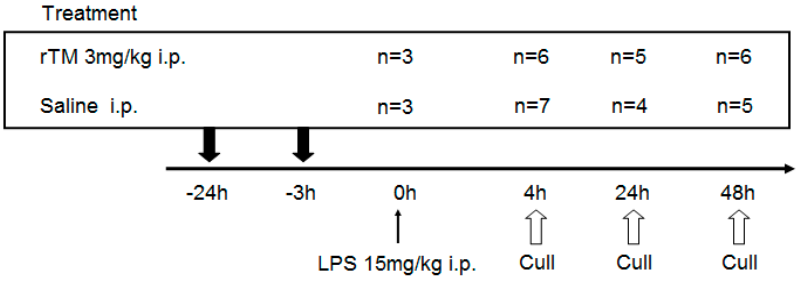
Figure 1. Experimental protocol of the lipopolysaccharide (LPS) model. A total of 53 C57BL / 6 mice were injected intraperitoneally with 15 mg / kg of lipopolysaccharide (LPS) at 0 h for the evaluation of survival rate and for measurements. Groups of mice were given either recombinant human soluble thrombomodulin (rTM) (3 mg / kg) as the rTM treatment or saline as control, twice ( − 24 and − 2 h), by intraperitoneal injection. Mice were culled at the following times (control groups and rTM treatment, respectively): 4 ( n = 7 and 6), 24 ( n = 4 and 5), and 48 h ( n = 5 and 6). Specimens were collected on an hourly schedule.